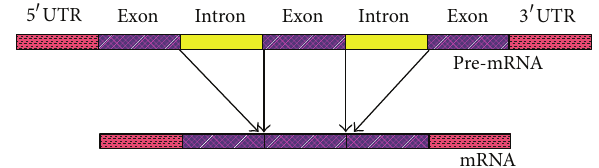
Figure 1: An illustration of pre-mRNA to mature